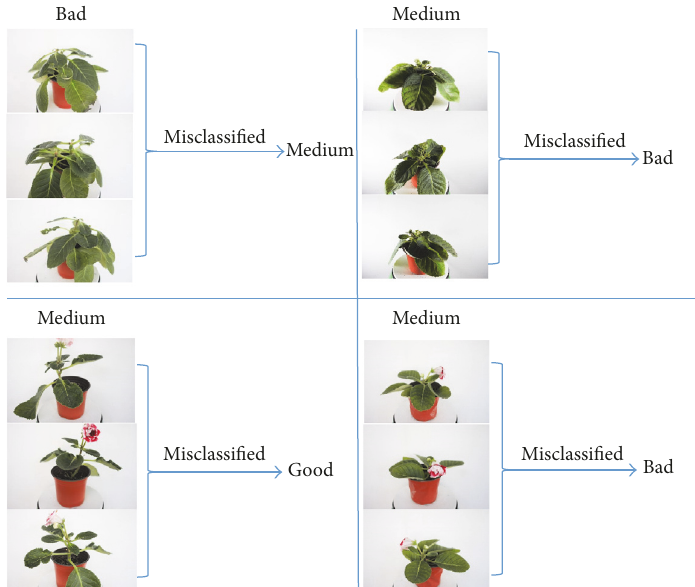
Figure 6: Examples of misclassified classes. This figure shows four misclassified samples. For example, the first sample in this figure which belongs to the bad class is misclassified to the medium class by our CNN model.